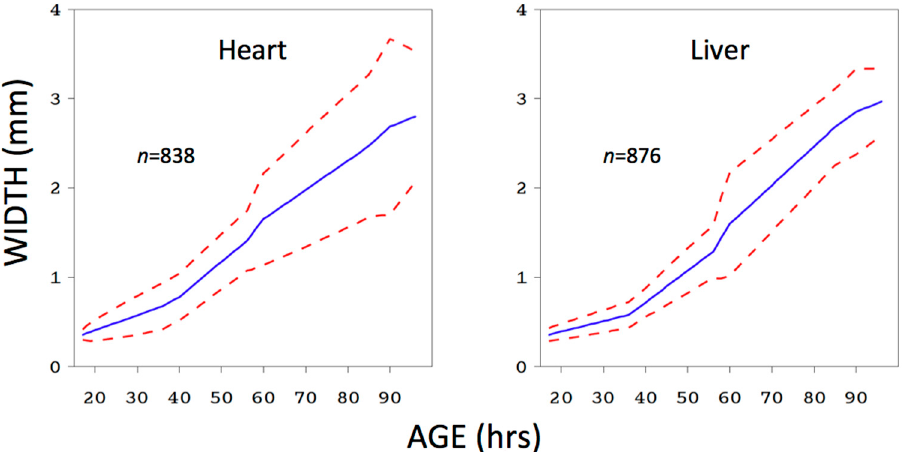
Figure 2. Chrysomya megacephala larval mean width as a function of age at 25.8 ◦ C and fed either pork heart or pork liver. The data are from [25]. Red dotted lines show 95% inverse prediction confidence bands [12]. Although there was a significant effect of food type on size ( F = 18.27, df = 8/700, p < 0.0001), when the liver model was used to predict the age of all heart larvae, more than 95% of inverse prediction confidence sets on age included the true